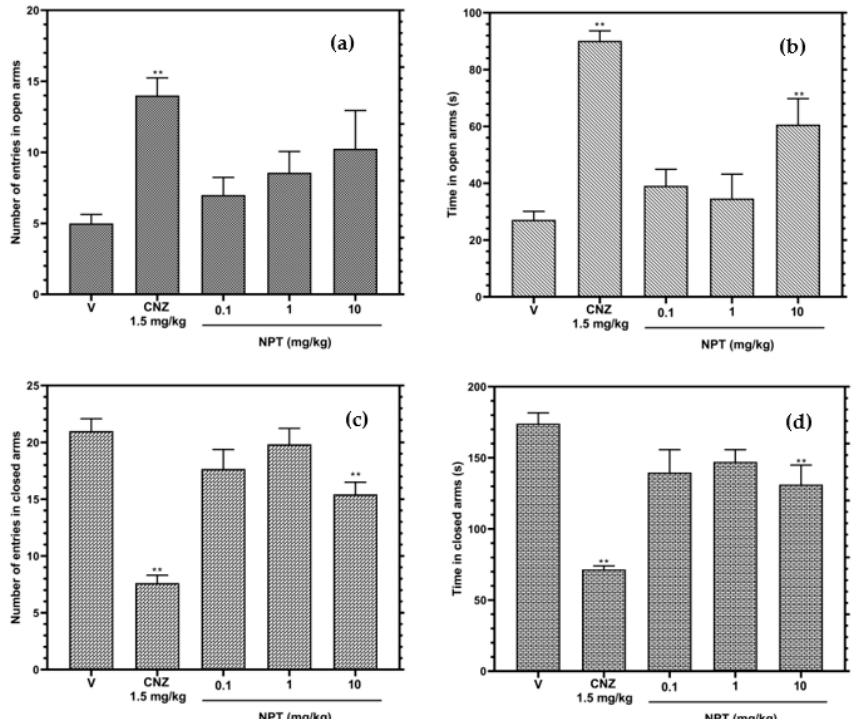
Figure 3. Anxiolytic-like effects of NPT (0.1–10 mg/kg p.o.) were assessed by the number of admissions in open ( a ) and closed arms ( c ) and the time elapsed in open ( b ) and closed ( d ) arms in the EPMT for 5 min. The reference drug was 1.5 mg/kg p.o. clonazepam (CNZ). The results of all experimental groups are reported as the mean values ( ± SEM). n = 8, ** p < 0.05 regarding to the vehicle group (indicated as V).